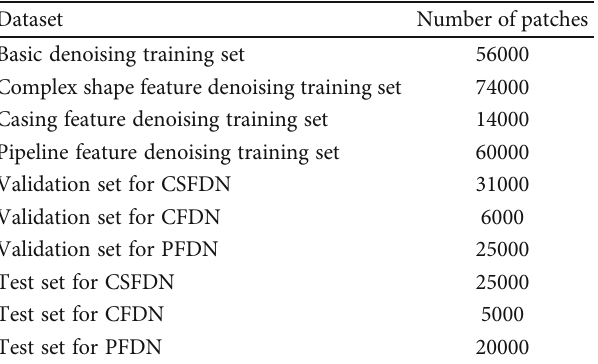
Table 1: The number of patches contained in each dataset.